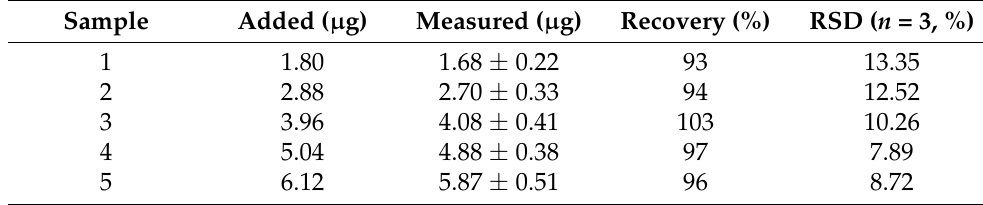
Table 1. Recoveries of CP from spiked samples.